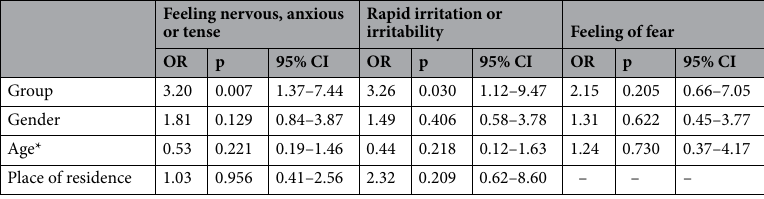
Table 8. Multivariate analysis of analyzed variables in Group Ia and Ib. * As binary value ≤ 60 years old and > 60 years old.